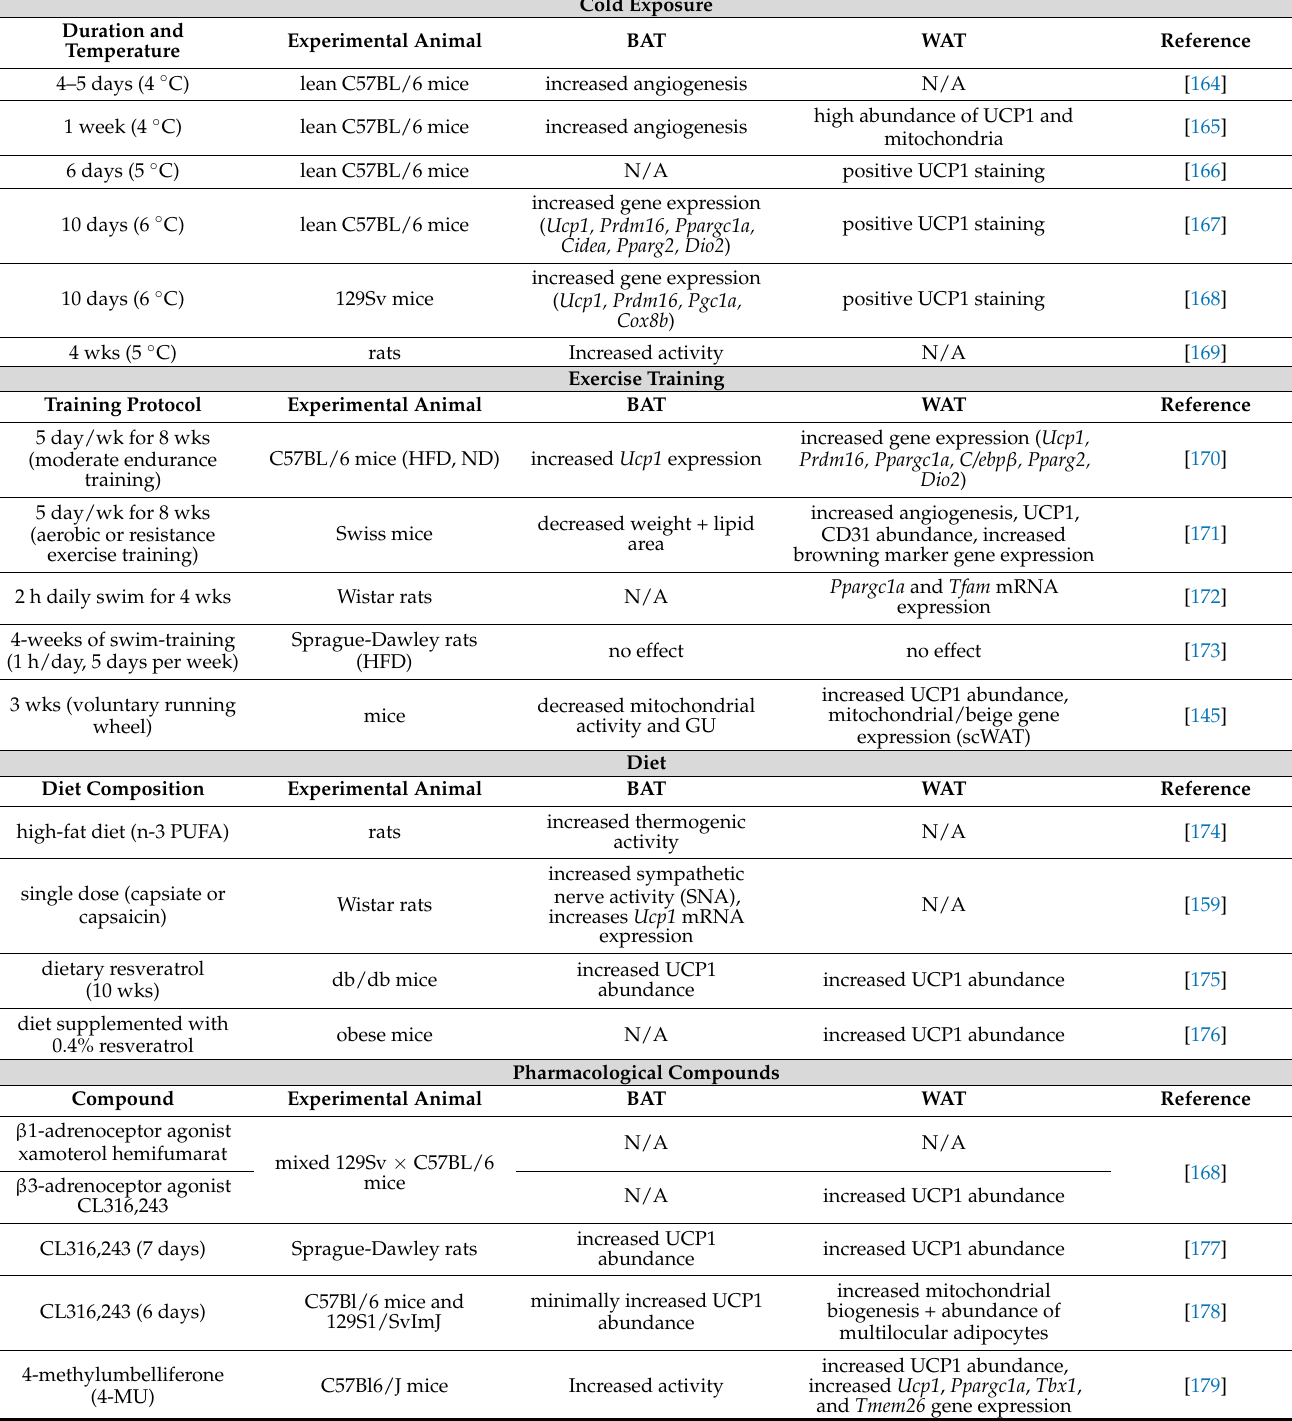
Table 1. Impacts of cold exposure, exercise interventions, dietary composition, and pharmacological compounds on BAT and WAT metabolism in